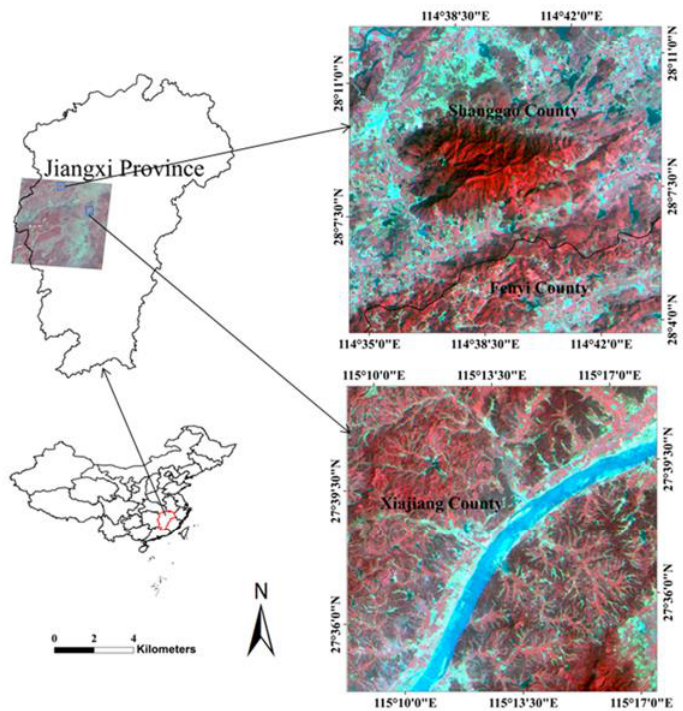
Figure 1. Geolocation of the study area. Two subset images ( upper ): area A and ( lower ): area B in false-color (R: band 4, G: band 3, and B: band 2) were used to perform the spectral shape-based image classification.